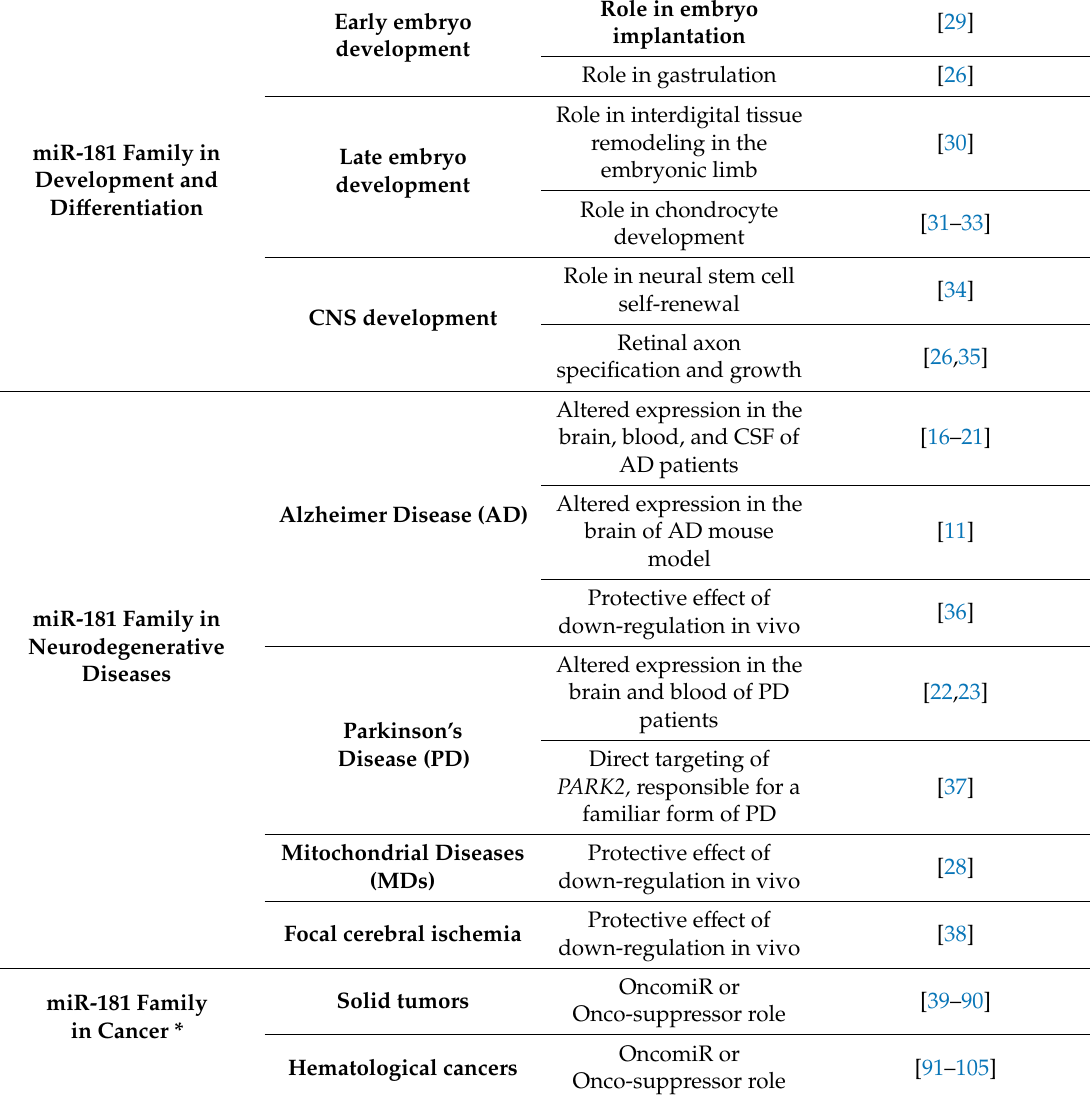
Table 1. The miR-181 family in development, di ff erentiation, neurodegenerative diseases, and